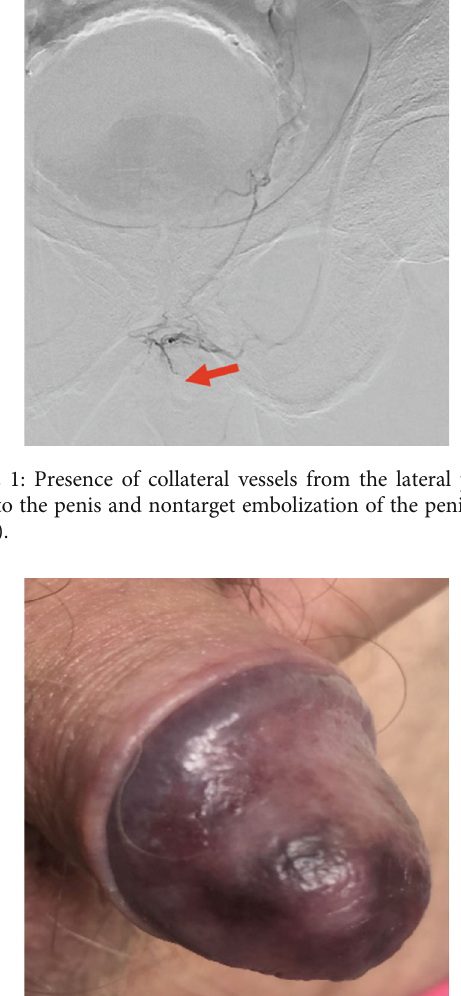
Figure 2: The appearance of penile glans necrosis at day 5 of